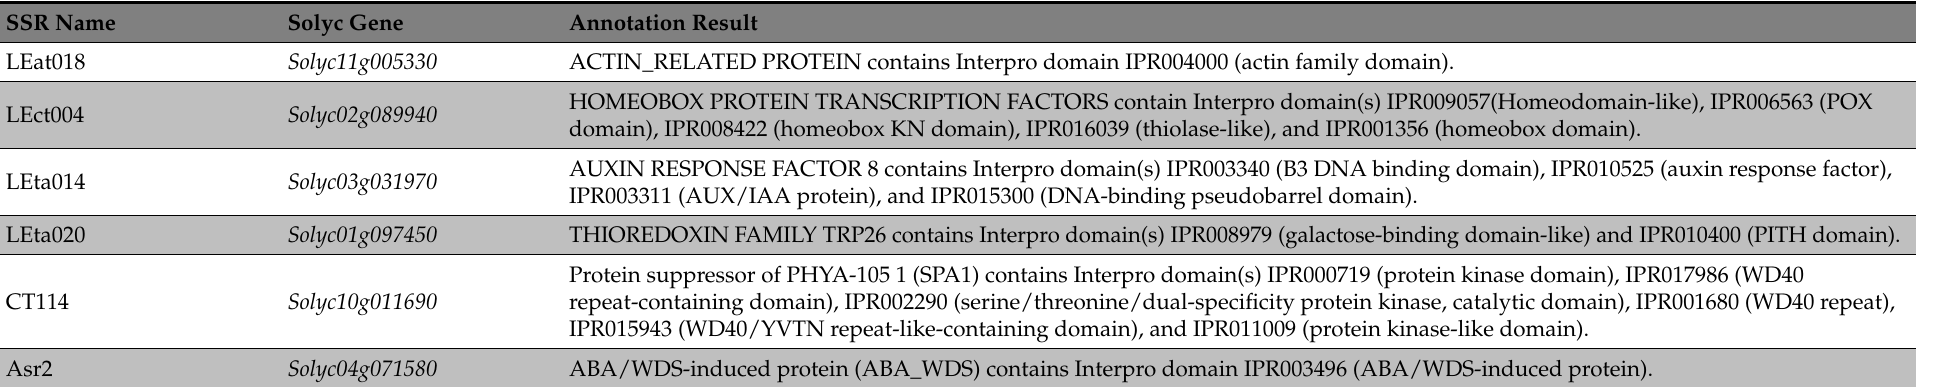
Table 5. BLAST corresponding Solyc ( Solanum lycopersicum ) gene sequences and annotation for SSR marker